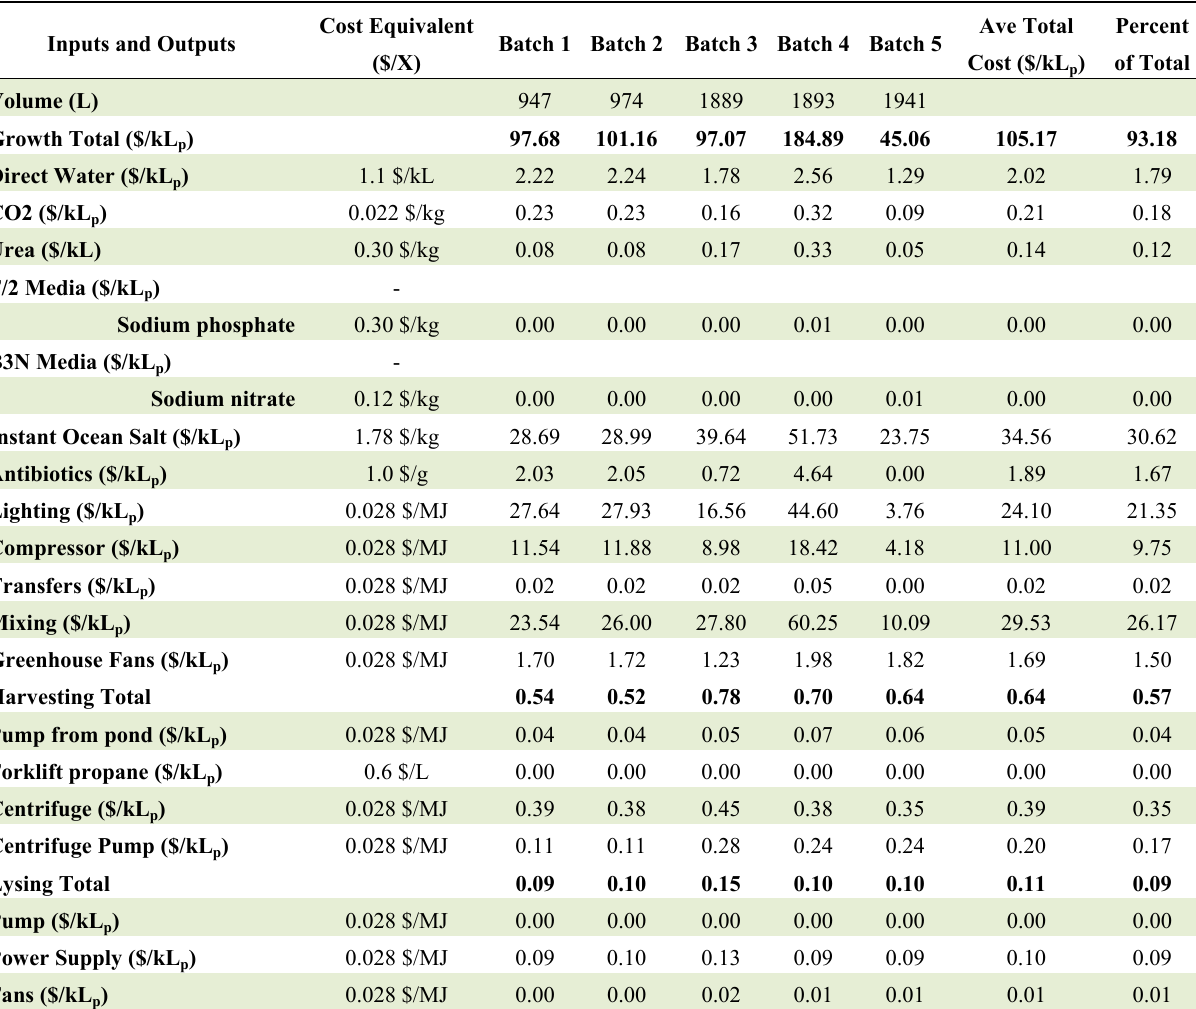
Table 1A. Experimental Case Inputs and Outputs. Data are reported in units of dollars per kL of processed volume ($/kL ) unless otherwise p